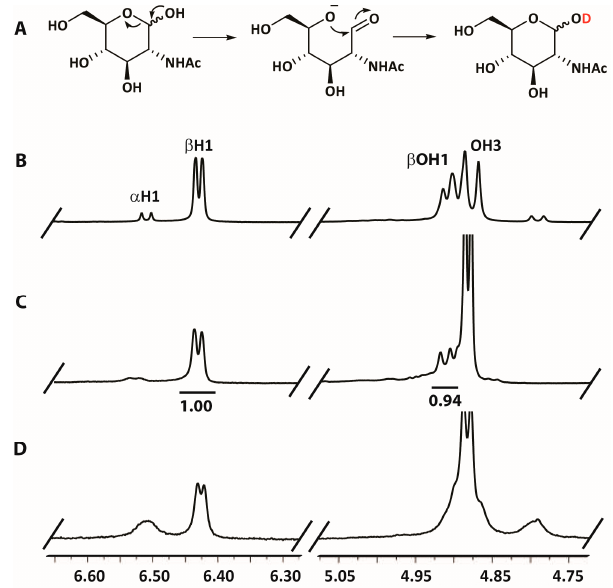
Figure 5. ( A ) : Reaction scheme of the hydrogen/deuterium exchange on the anomeric alcohol of GlcNAc. The pyranose ring opening involves the formation of a double bond at the anomeric carbon to form an intermediate aldehyde. The C ‐ 5 oxygen of the intermediate then attacks the anomeric carbon, closing the ring again. The anomeric oxygen is deuterated by the solvent; ( B ) : 1 H ‐ NMR spectrum of GlcNAc in DMSO ‐ d 6 ; ( C ) : 1 H ‐ NMR spectrum of the reaction mixture containing 20 mM GlcNAc and inactivated PhGn2E in D 2 O after 15 min incubation at 37 °C (spectrum was recorded in DMSO ‐ d 6 ); ( D ) : 1 H ‐ NMR spectrum of the reaction mixture containing 20 mM GlcNAc and PhGn2E in D 2 O after 15 min incubation at 37 °C (spectrum was recorded in DMSO ‐ d 6 ).